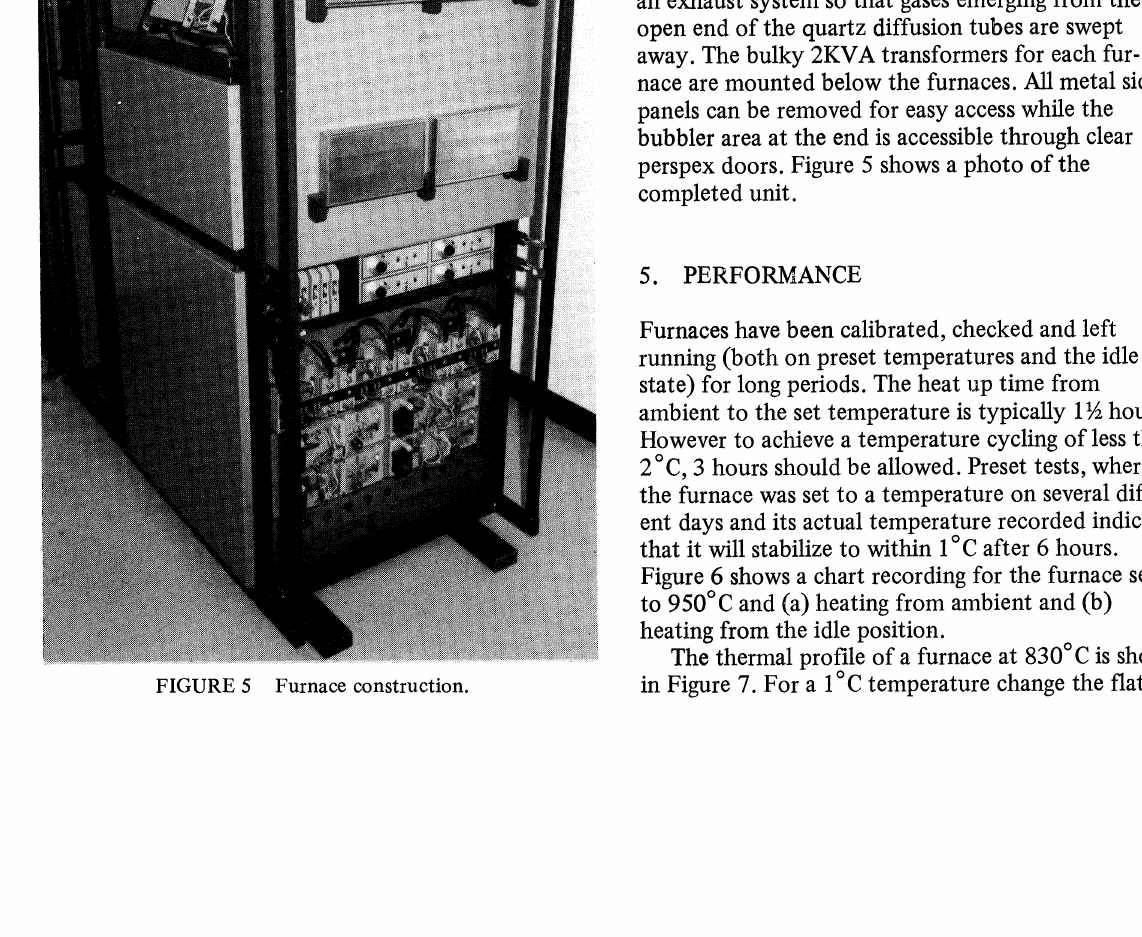
FIGURE 6 Furnace